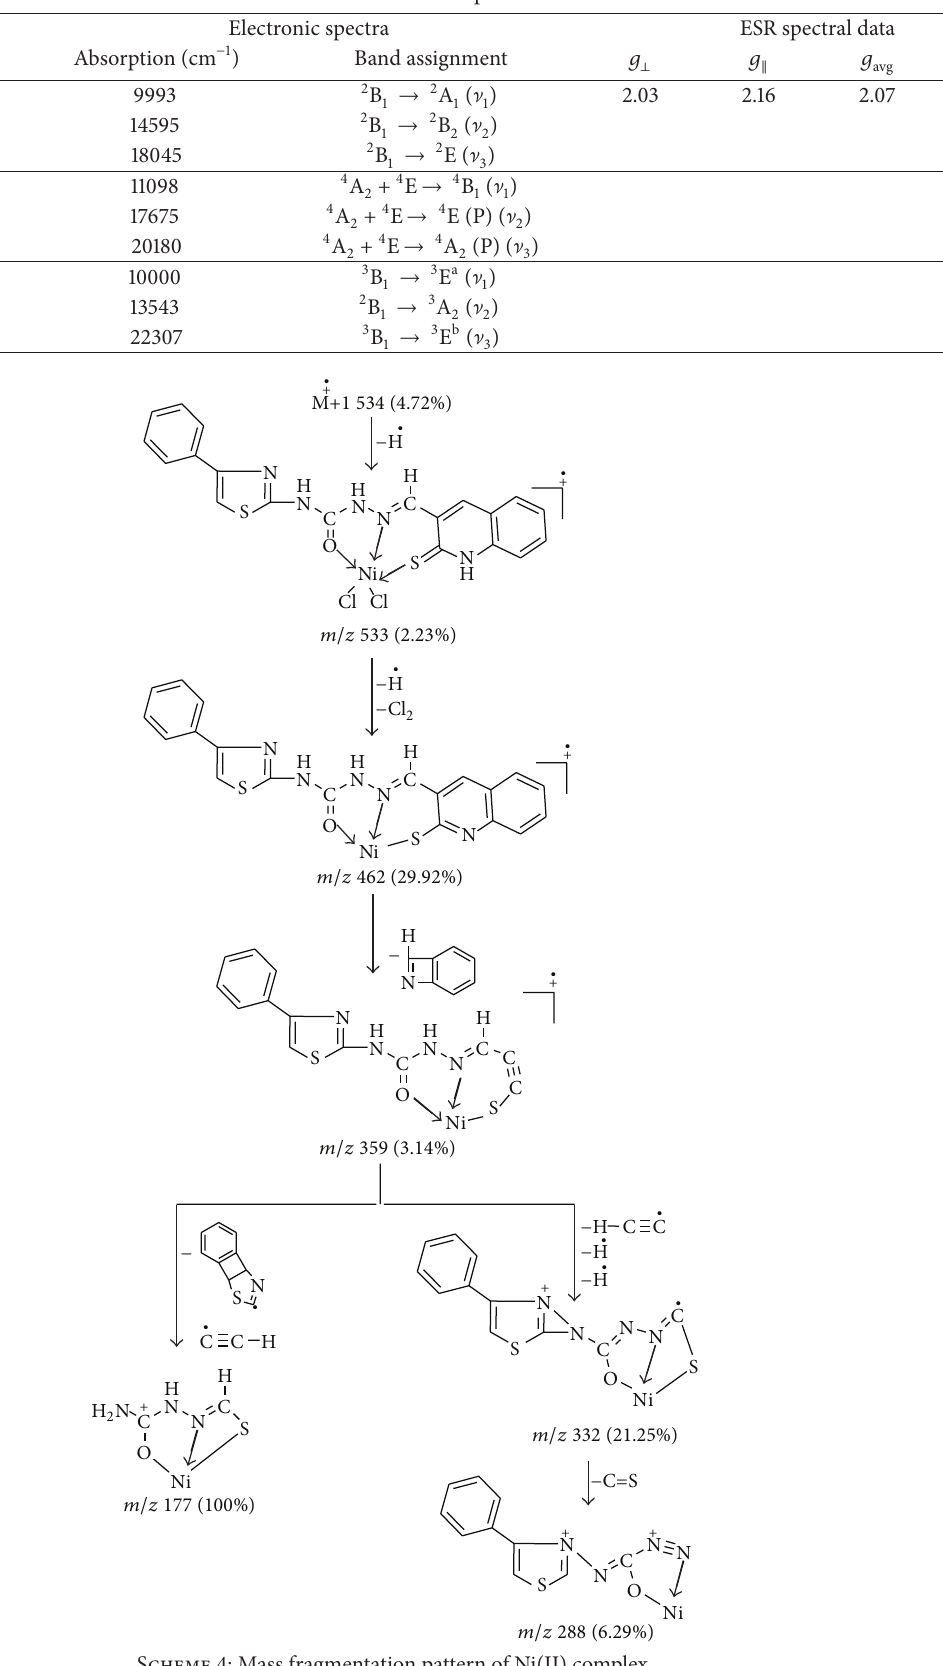
Table 3: Electronic and ESR spectral data.